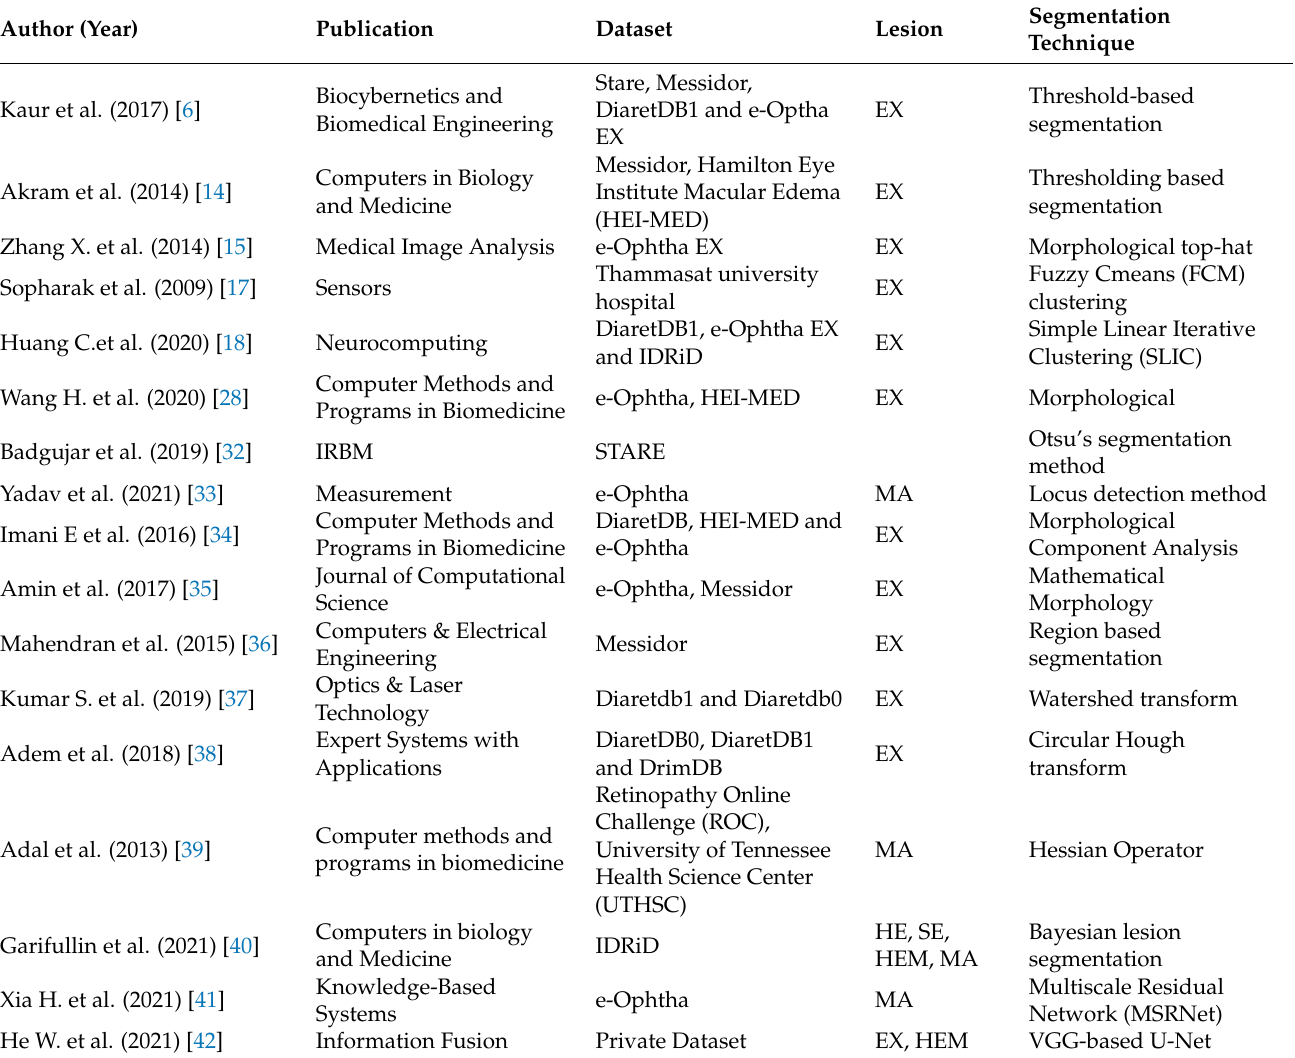
Table 5. Image segmentation methods used in the